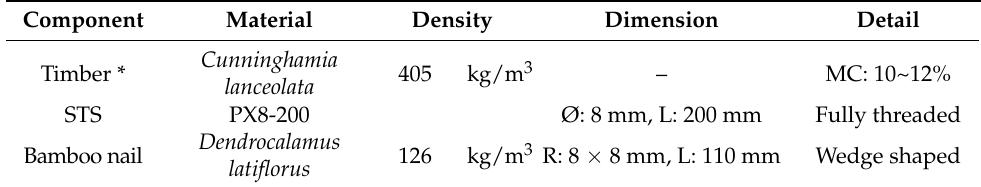
Table 1. Associated materials in the rotational and shear